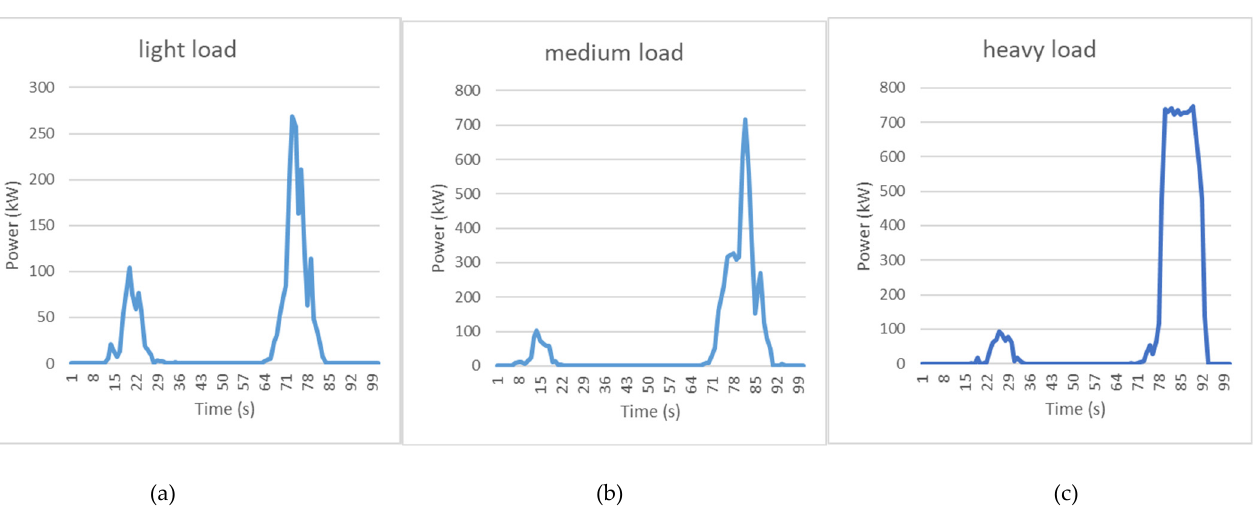
Figure 7. Crane lifting load density function.